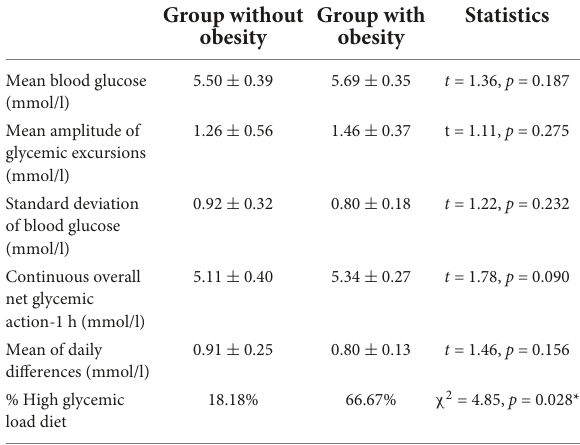
TABLE 2 Results extracted from continuous glucose monitoring and dietary logs in each group. Group without Group with obesity obesity